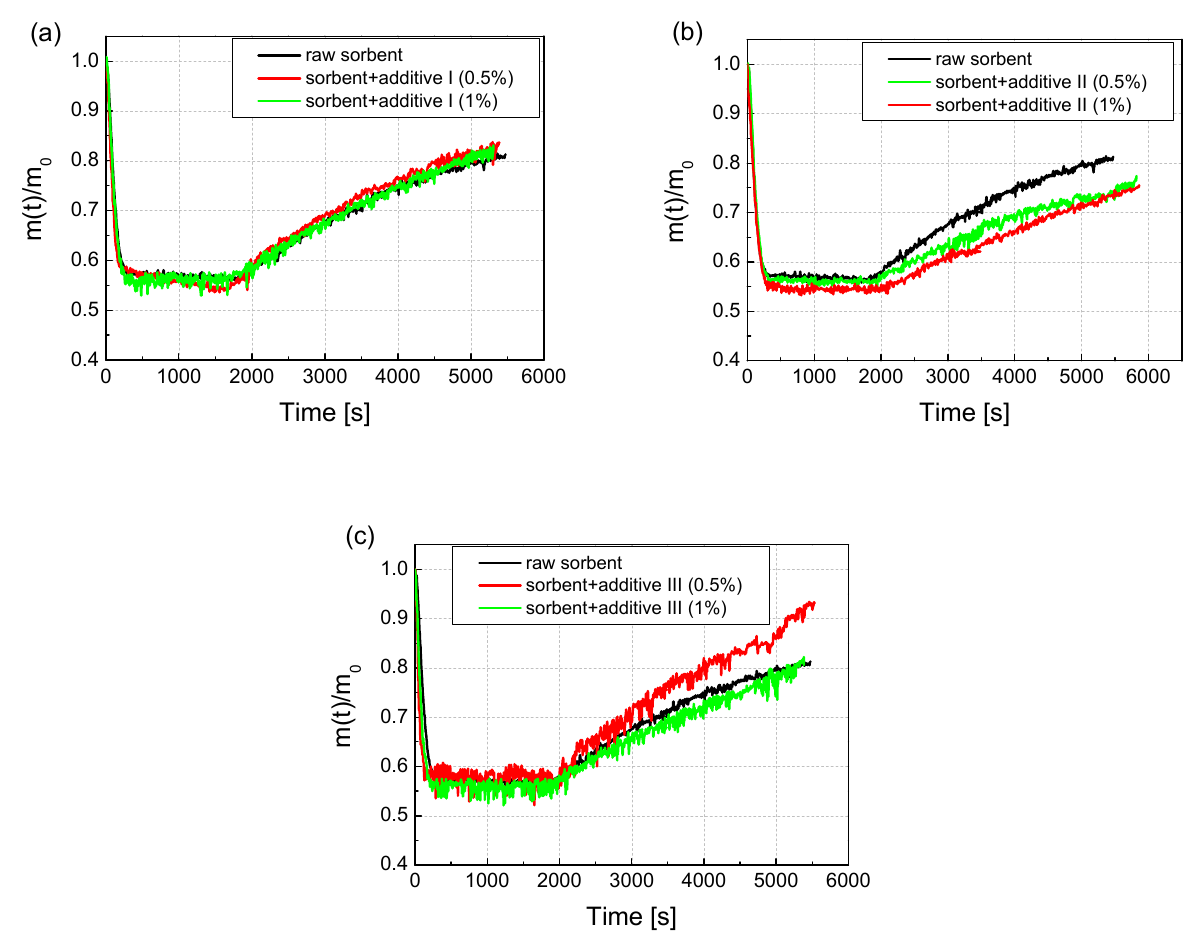
Figure 5. The course of mass changes during the reactivity test for the raw sorbent, and ( a ) the sorbent modified with Additive 1 in the amount of 0.5% and 1%; ( b ) sorbent modified with Additive 2 in an amount of 0.5% and 1%; ( c ) sorbent modified with Additive 3 in an amount of 0.5% and 1%.